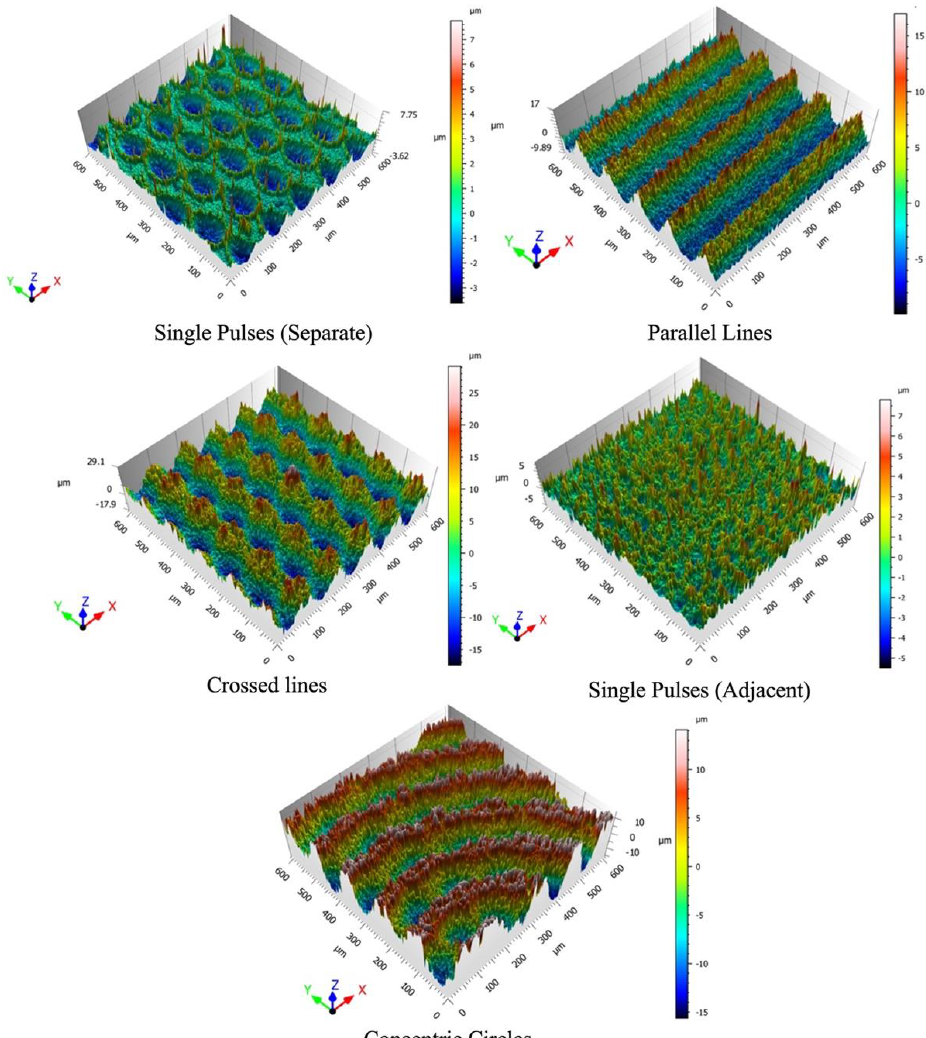
Figure 6. Three-dimensional topography maps of laser-textured surfaces without coating obtained with all scanning strategies and an average laser power of 17 W.